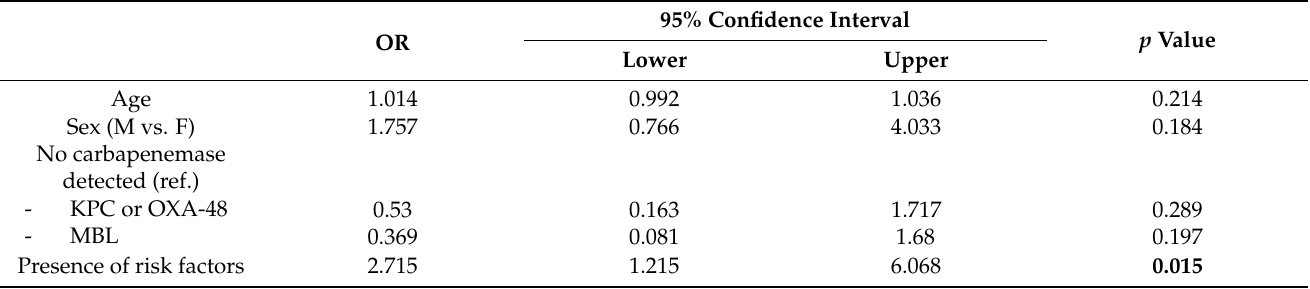
Table 5. Independent predictors of 90-day mortality at multivariate logistic regression